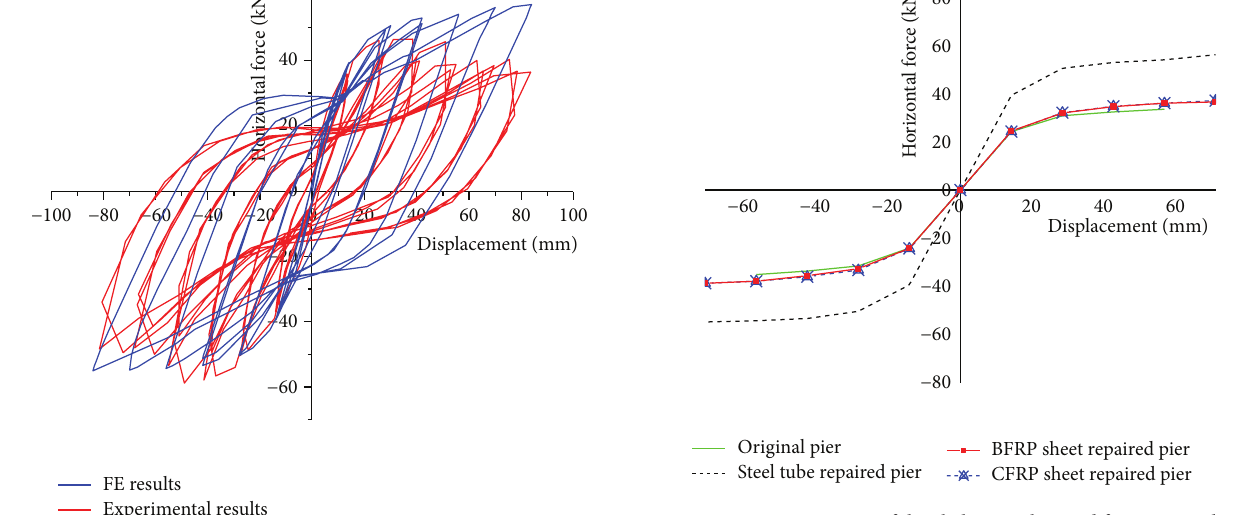
Figure 14: Comparisons of the skeletons obtained from FE